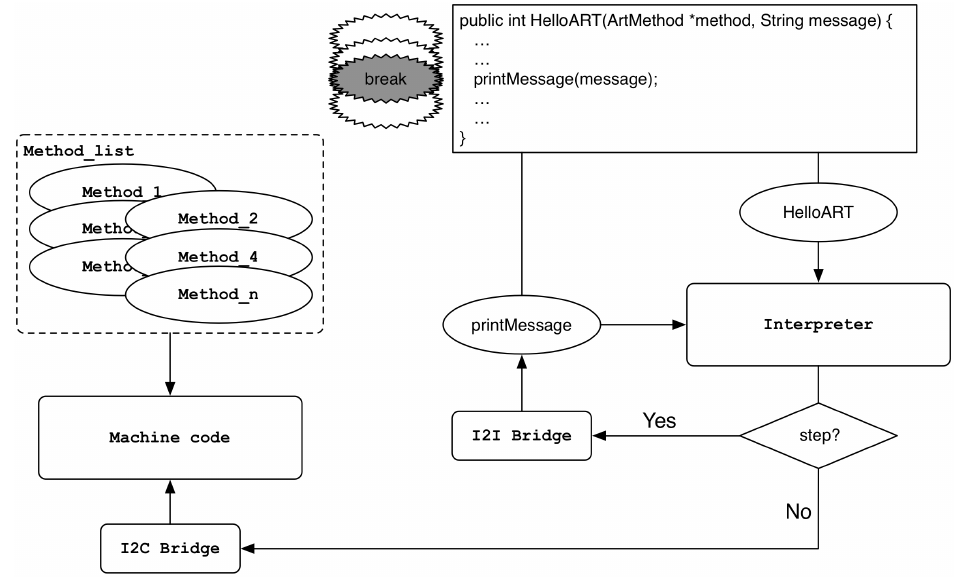
Figure 5. Set the event at method’s